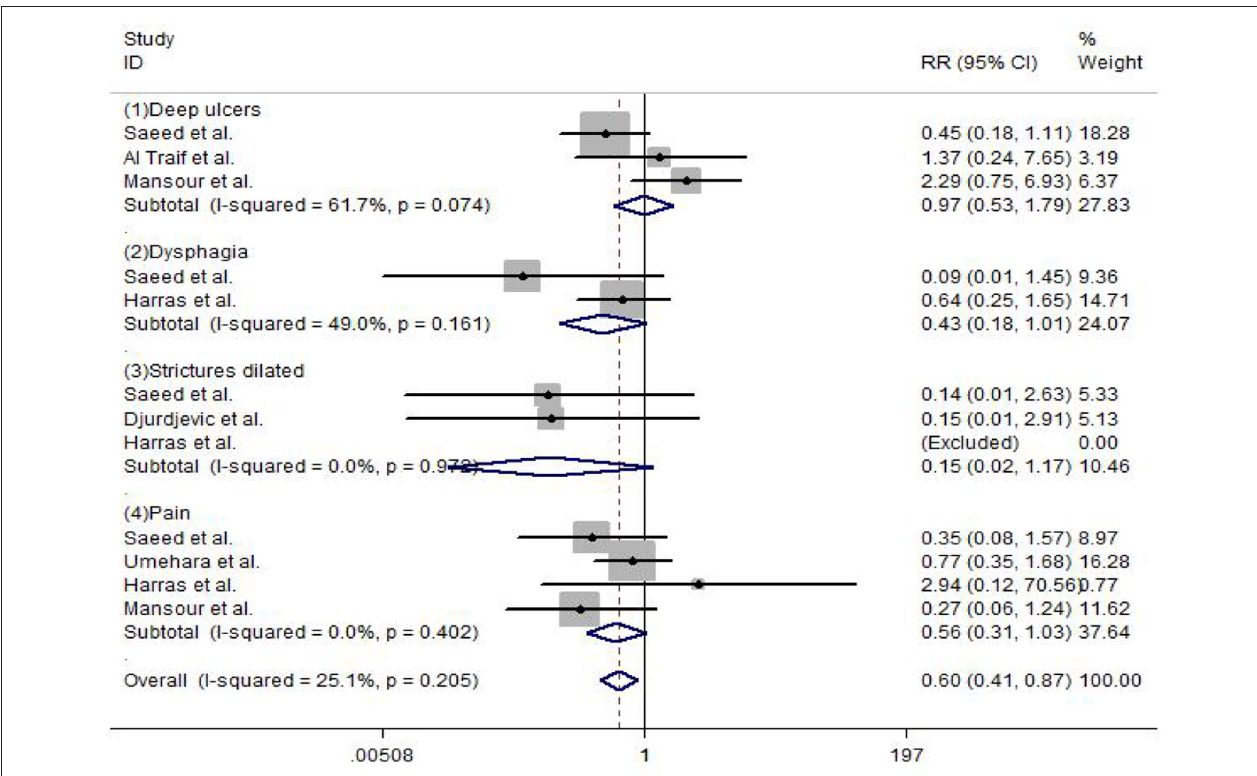
FIGURE 8 | Forest plot of the meta-analysis comparing EVL and EVL + EIS in complications. EIS, endoscopic injection sclerotherapy; EVL, endoscopic variceal